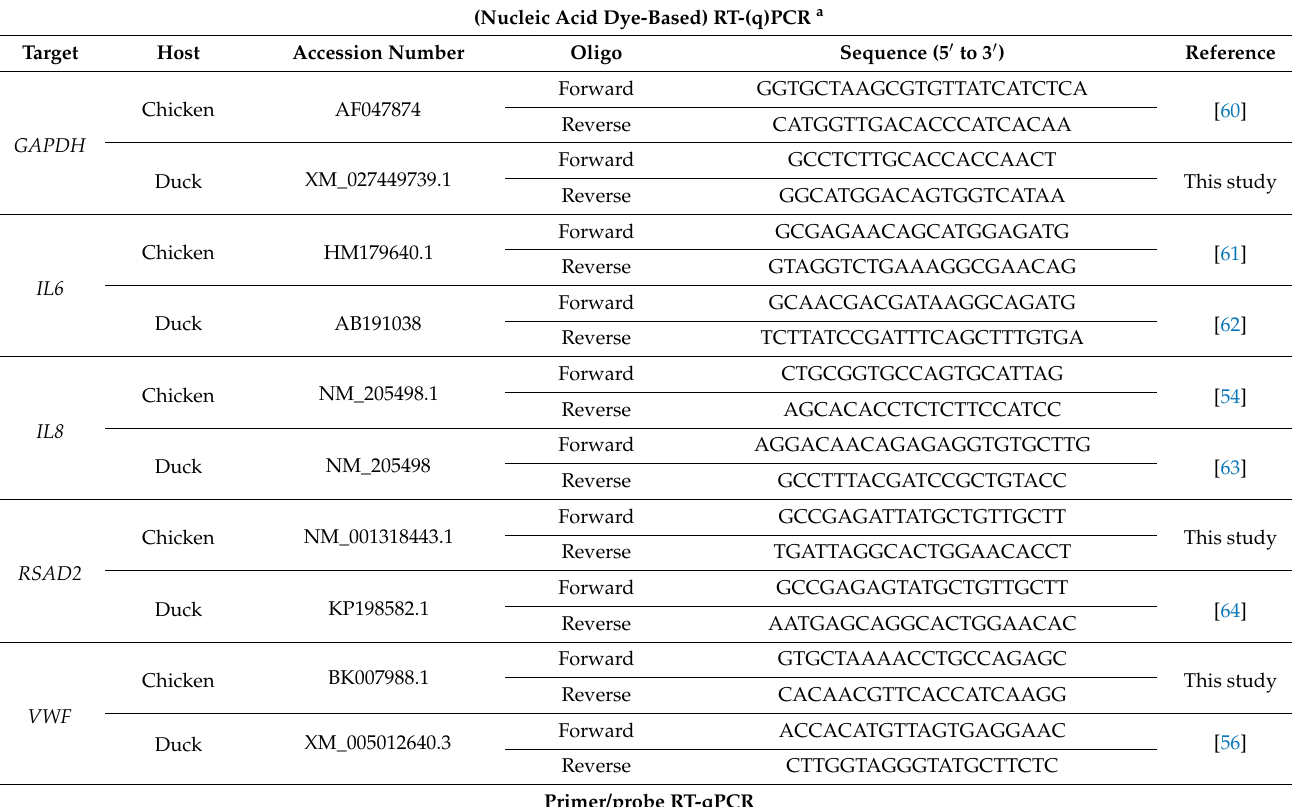
Table 1. Target genes and primers and probes sequences used during RT-(q)PCR. (Nucleic Acid Dye-Based) RT-(q)PCR